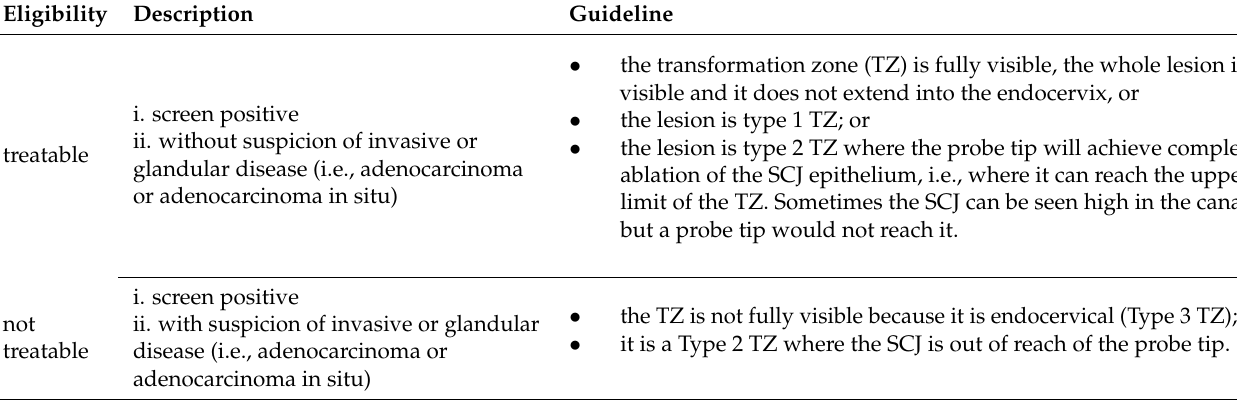
Table 1. WHO guideline: eligibility for thermal ablation and